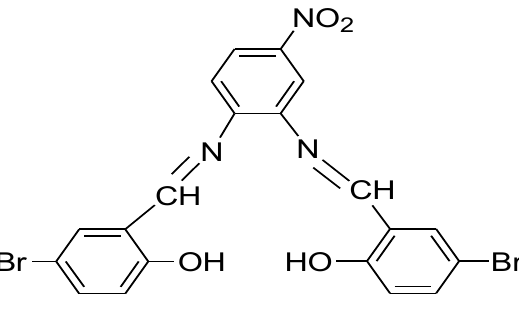
Figure 1. bis (5-bramosalicylidene)-4-nitrophenylene-1,2-diamine (H